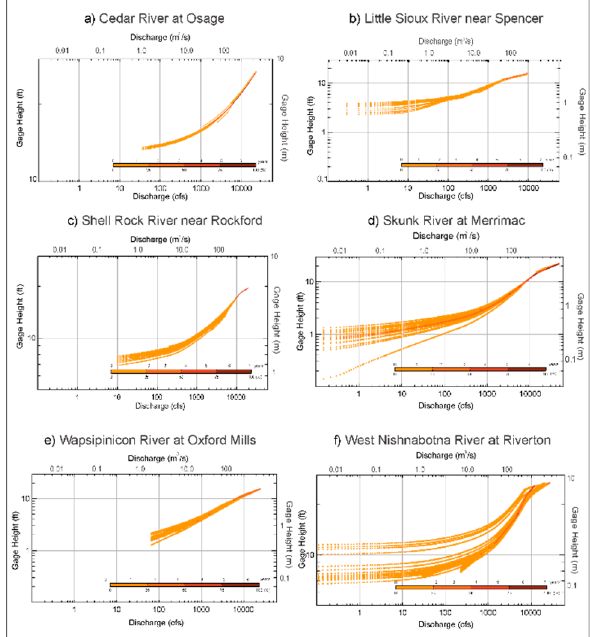
Figure 18. Duration (in years) of individual stage–discharge relationships. ( a ) Cedar River at Osage; ( b ) Little Sioux River near Spencer; ( c ) Shell Rock River near Rockford; ( d ) Skunk river at Merrimac; ( e ) Wapsipinicon River at Oxford Mills; and ( f ) West Nishnabotna River near Riverton.